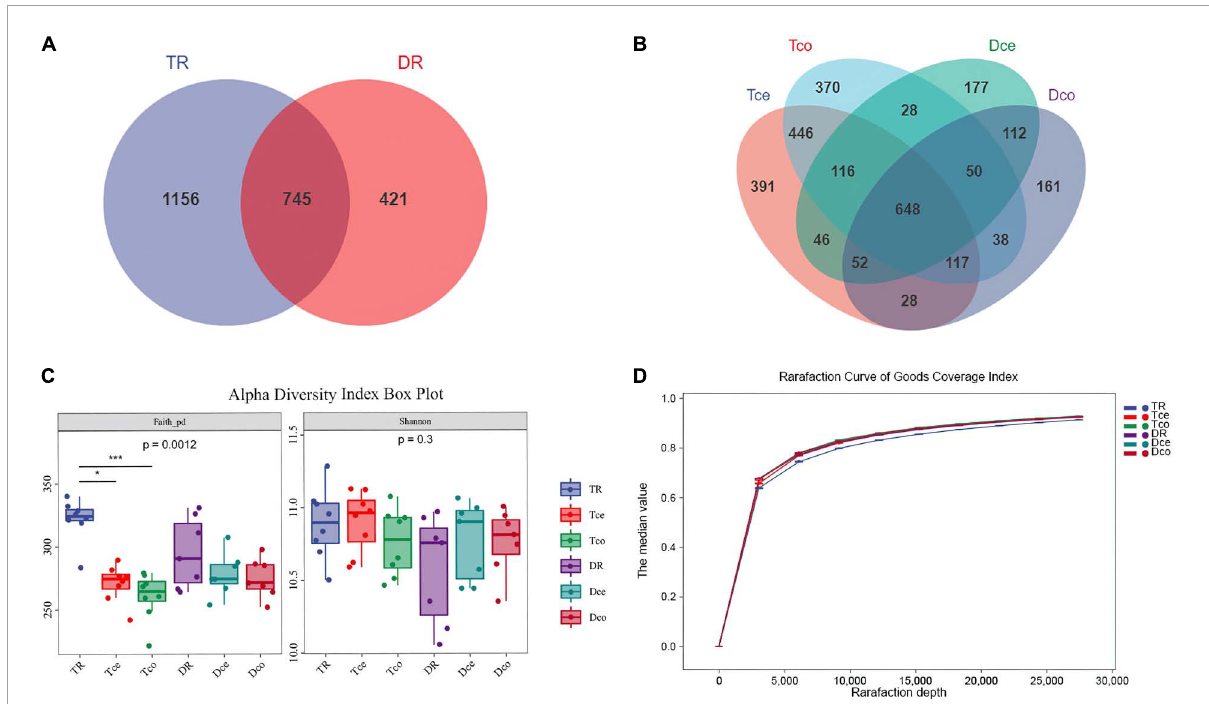
FIGURE2 Sequencing results and statistical analysis of diversity. (A) Venn diagram showing the operational taxonomic units (OTUs) shared among the rumen. (B) Venn diagram showing the OTUs shared between the cecum-colon segments. (C) The Faith’s phylogenetic diversity (PD) and Shannon indices of six groups. (D) Rarefaction curve of Good’s coverage index. Each curve represents the mean within the